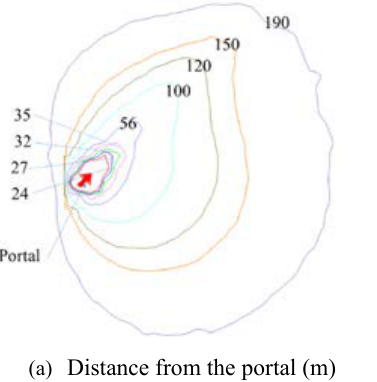
Fig. 8: Mean CO concentration at the eastern portal of the southern tunnel of the Niayesh tunnel for short-time dispersion modeling (with detail of distances (a) and CO concentration (b))-5 m